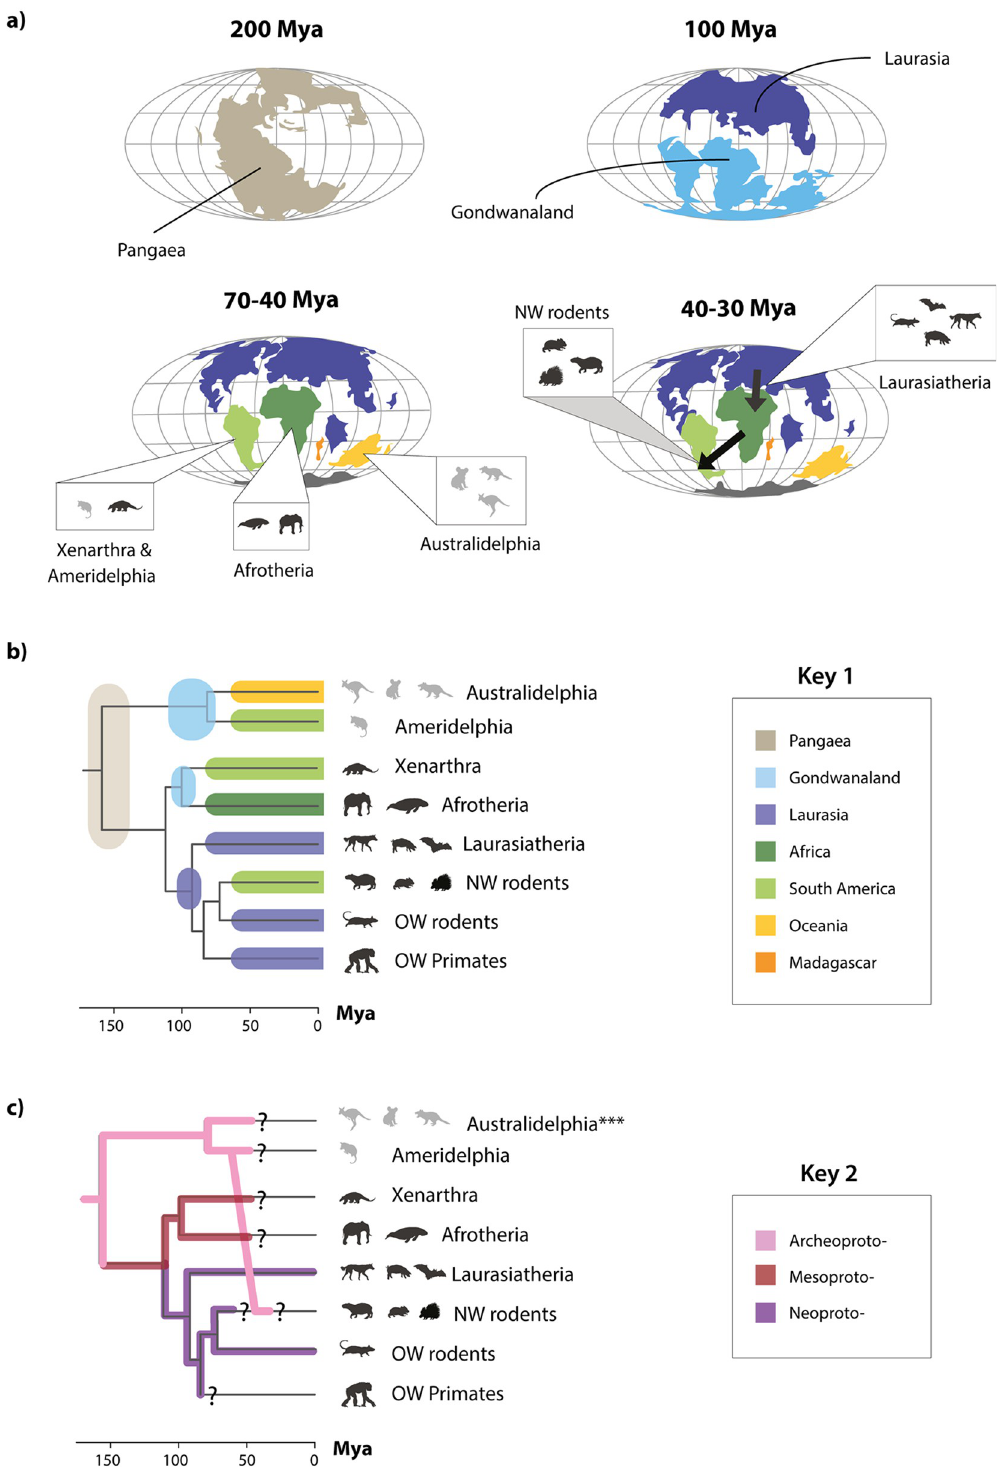
Fig 7. Protoparvovirus evolution has been shaped by mammalian vicariance. (a) Mollweide projection maps showing how patterns of continental drift from 200–35 led to periods of biogeographic isolation for terrestrial mammals in Laurasia (Europe and Asia), South America, Australia, Africa, and Madagascar. The resulting vicariance is thought to have contributed to the diversification of mammals, reflected in the mammalian phylogeny as shown in panel (b). Most